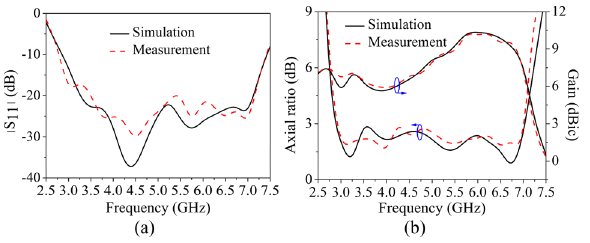
Figure 9. Simulated and measured reflection coefficients, ARs and gain of the prototype. ( a ) Reflection coefficients. ( b ) ARs and boresight gains.